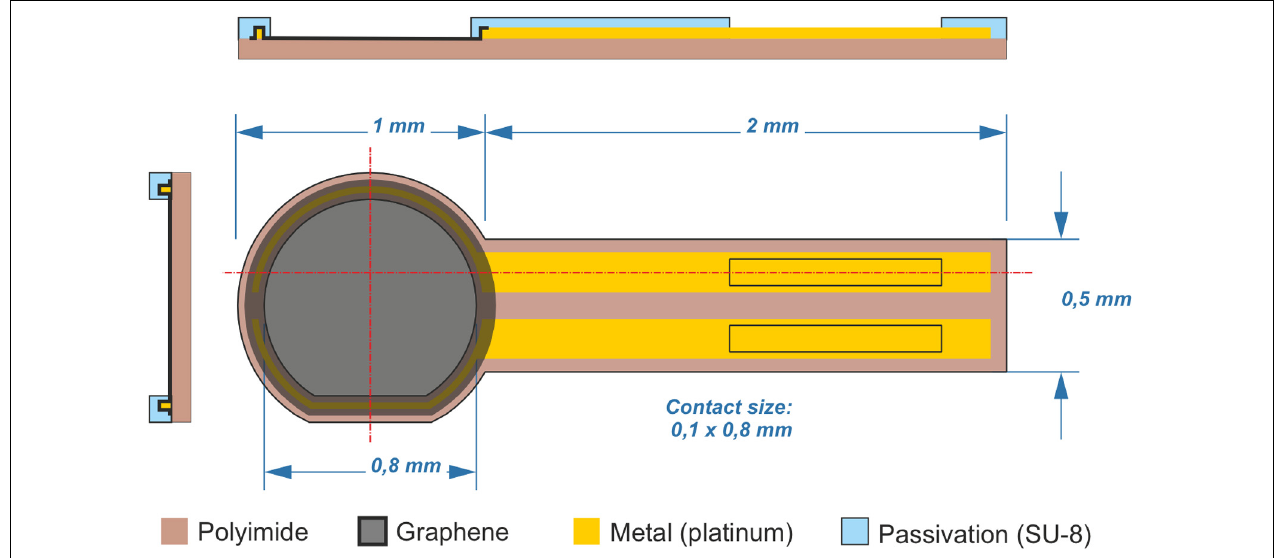
FIGURE 1 | Graphene-based implants. Orthogonal schemes of fabricated implants showing the side and top views. Graphene and platinum lines are passivated between polyimide and SU-8. Control implants have the same scheme without the graphene layer, exposing instead the bottom polyimide